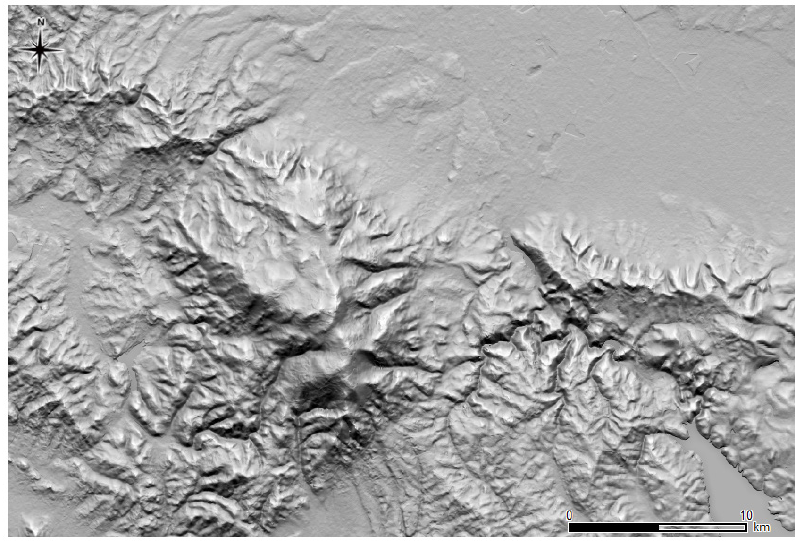
Fig. 3. Relief visualization with two-directional hillshade and